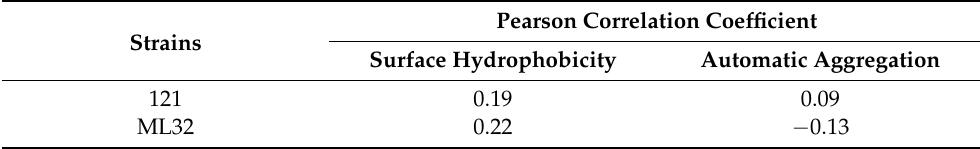
Table 3. The correlation analysis between the BaP binding percentage and surface properties of strains.